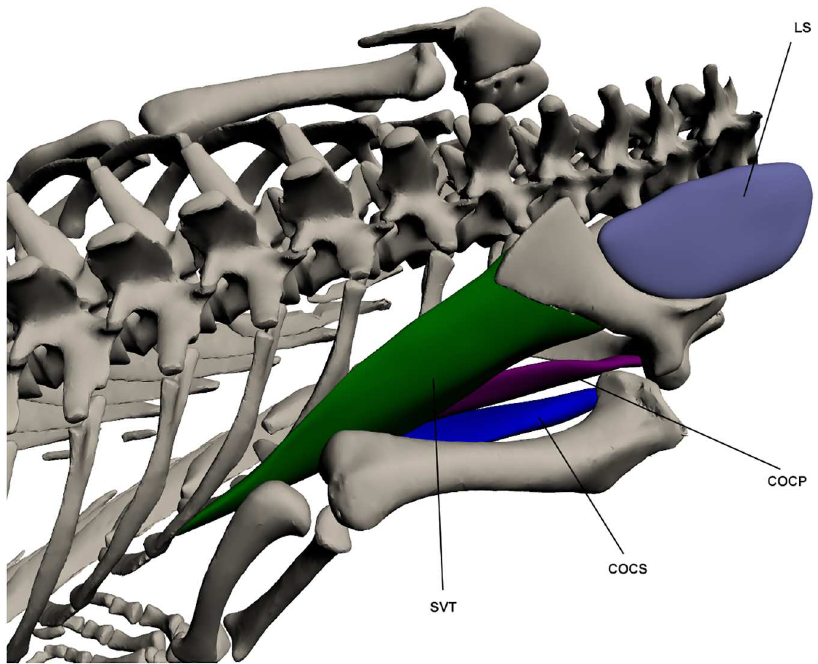
Fig 7. Deep extrinsic muscles of the forelimb. LS: Levator scapulae ,SVT: Serratus ventralis thoracis , COCS: Costocoracoideussuperficialis , COCP: C ostocoracoideus profundus .